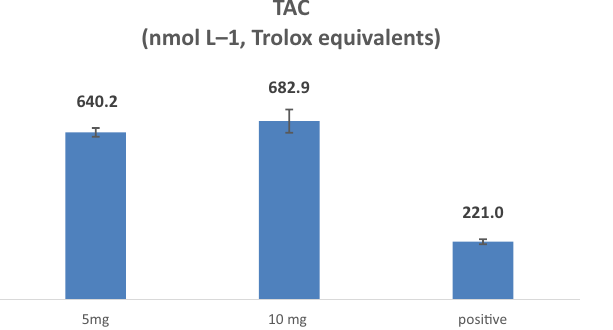
Figure 6. the TAC levels of ( 2a ) compound at 5 and 10 mg/ kg doses in comparison with positive control quercetin (10